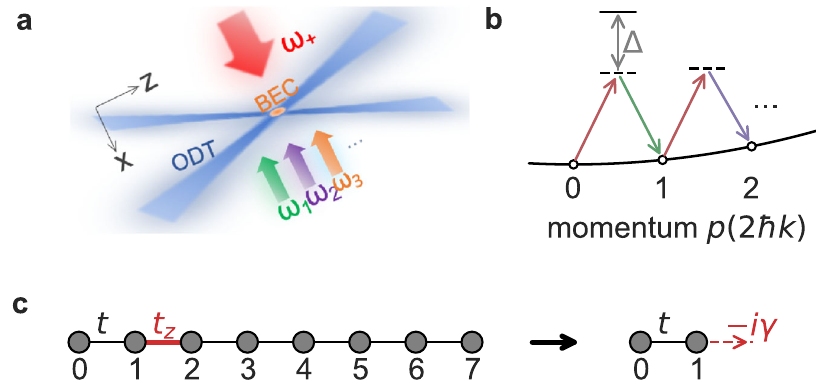
Fig. 2 Realization of a dissipative two-level system in momentum-state lattice. a Schematic of the experimental setup. A Bose – Einstein condensate interacts with a pair of counter-propagating Bragg lasers in an optical dipole trap. The beam propagating along the − x direction contains multiple frequency components ( ω j with j ¼ 1 ; 2 ;::: ) whose intensities and frequencies can be precisely controlled (see Supplemental Information). b Each Bragg laser pair f ω þ ; ω n g triggers a resonant two-photon Bragg transition, coupling two neighboring momentum states j p n (cid:2) 1 i $ j p n i along the momentum lattice. c The resulting 8-site momentum lattice is mapped into a dissipative two-level system with tunable loss rate γ ð τ Þ , by treating the sites fj 0 i ; j 1 ig as the system, and j n (cid:6) 2 i as a